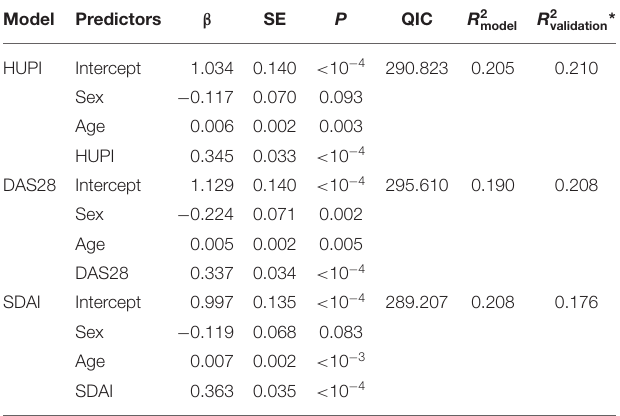
TABLE 2 | Models for IL-6 levels comparing the performance of different indices. Model Predictors